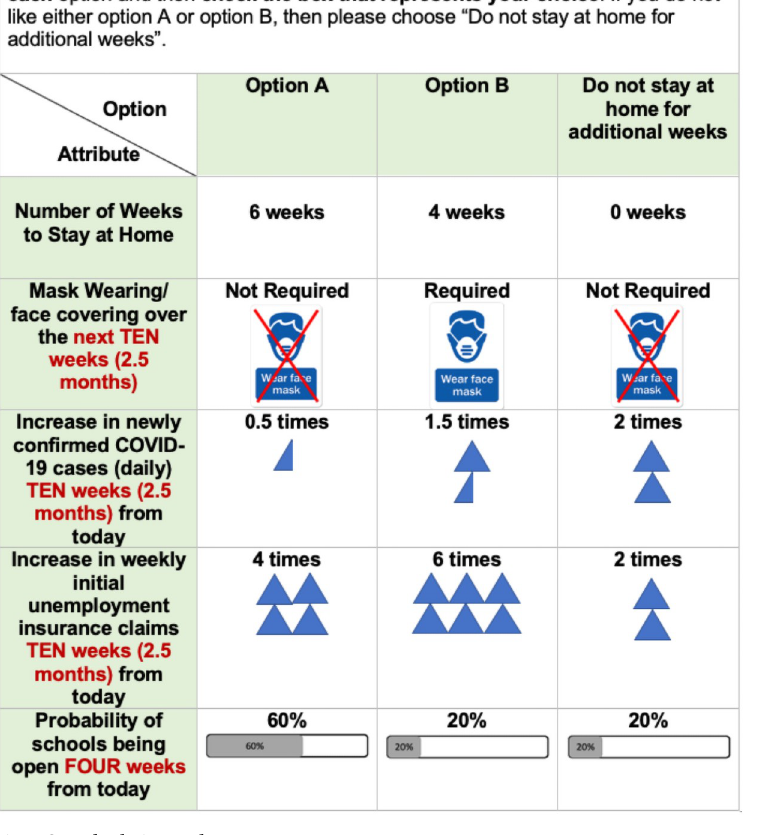
Fig 3. Sample choice